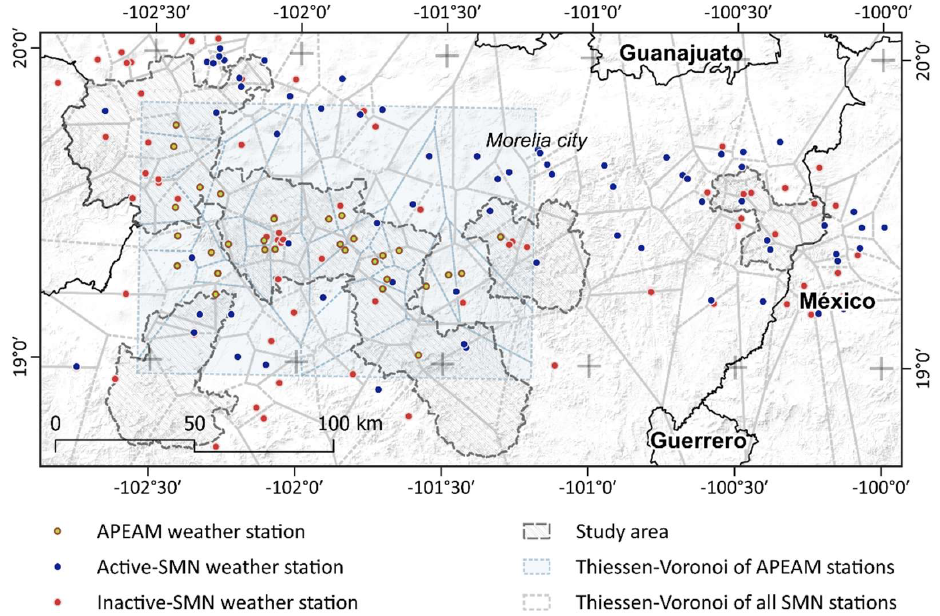
Figure 3. Location of the different weather stations considered for atmospheric variables analysis.